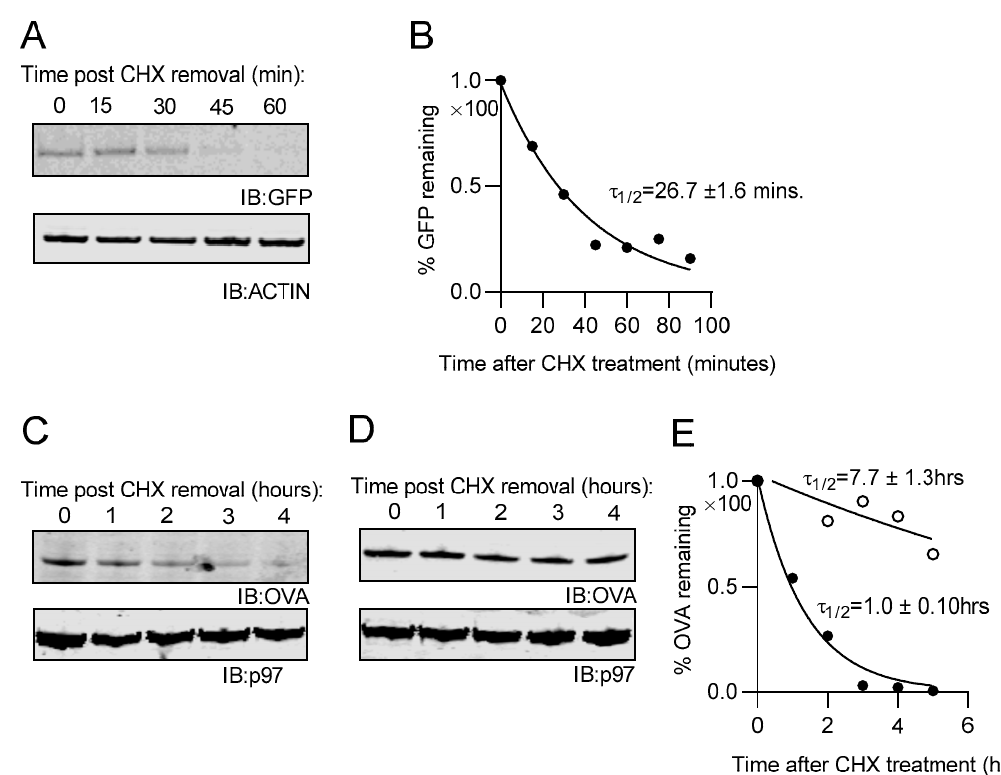
Figure 2. Half-life determination of the non-cleavable forms of NEDD8-GFP and NEDD8-OVA in EL4 cells. EL4 cells stably expressing model proteins were treated with CHX to prevent translation of new proteins. ( A ) Cell lysates of NC NEDD8-GFP were created at indicated times after CHX treatment and analyzed by Western blot analysis. ( B ) Single phase exponential decay analysis was used to calculate the half-life of NC NEDD8-GFP, after quantification of bands from Western blot. The mean half-life of GFP was calculated from three independent experiments to be 26.7 ± 1.6 min. ( C , D ) Cell lysates for EL4/NC NEDD8-OVA and EL4 cells stably expressing OVA alone were made at indicated times (after CHX treatment) and analyzed by Western blot. ( E ) Half-lives for NC NEDD8-OVA (black circles) and OVA-alone (white circles) were calculated as described before. The calculated half-life was 1 ± 0.1 h for NC NEDD8-OVA and 7.7 ± 1.3 h for OVA-alone. Data shown is from one of three independent experiments performed. Half-lives shown are mean values obtained from three independent experiments. All western blot images were cropped to show relevant